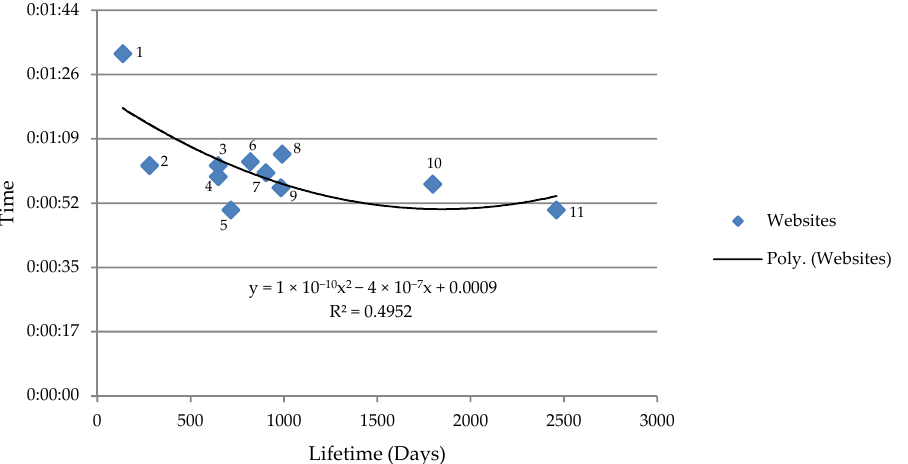
Figure 3. Average session consultation time in relation to the lifespan of each of the websites. (1) www.vaccinarsintrentino.org; (2) www.vaccinarsinellemarche.org; (3) www.vaccinarsincampania.org; (4) www.vaccinarsinlazio.org; (5) www. vaccinarsinliguria.org; (6) www.vaccinrsinsardegna.org; (7) www.vaccinarsinsicilia.org; (8) www.vaccinarsinpuglia.org; (9) www.vaccinarsintoscana.org; (10) www.vaccinarsinveneto.org; and (11)